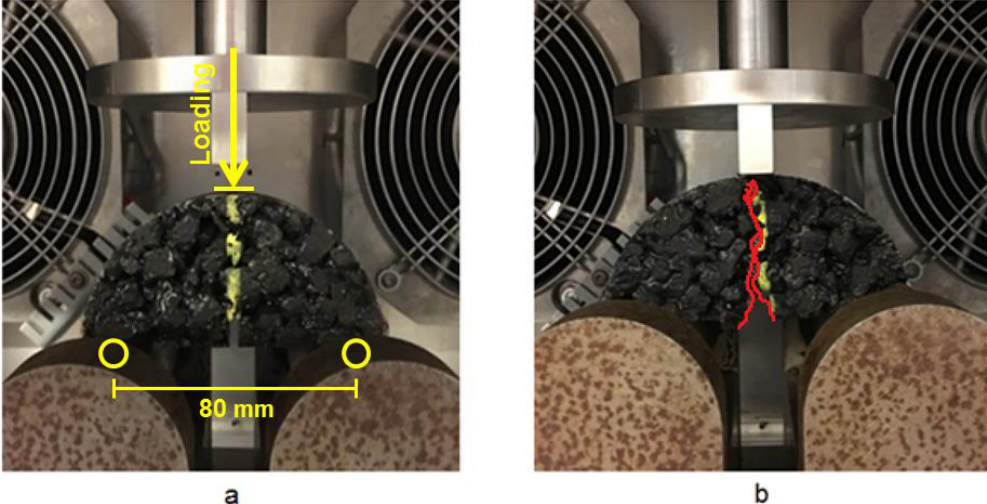
Figure 6. ( a ) SCB tests setup and ( b ) Fractured specimen after test.